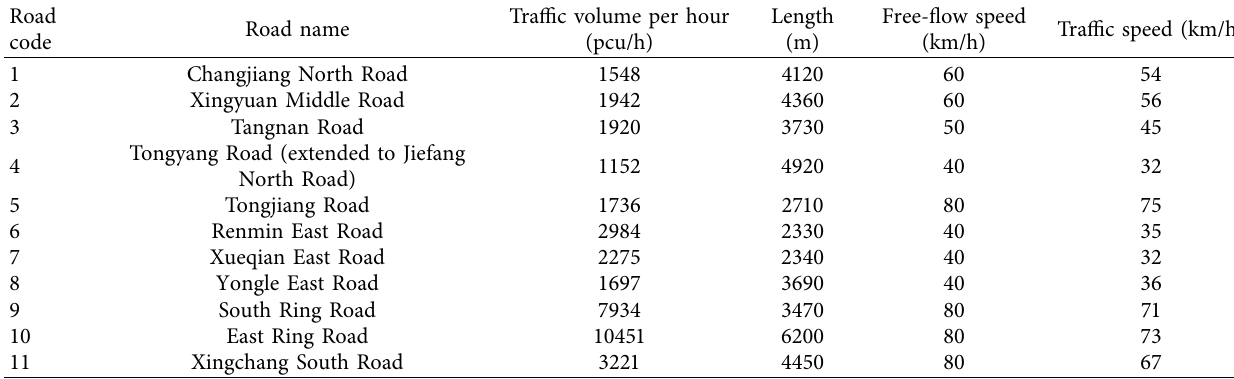
Table 7: Operation efficiency of the road network in the investigated